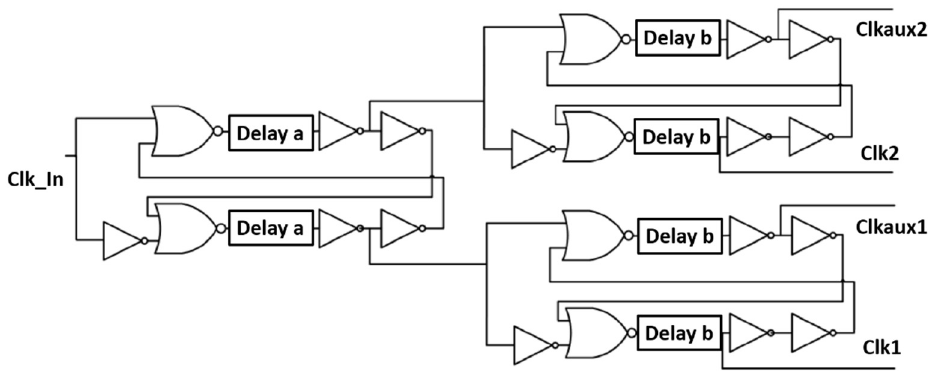
Figure 8. Phase generation circuit.